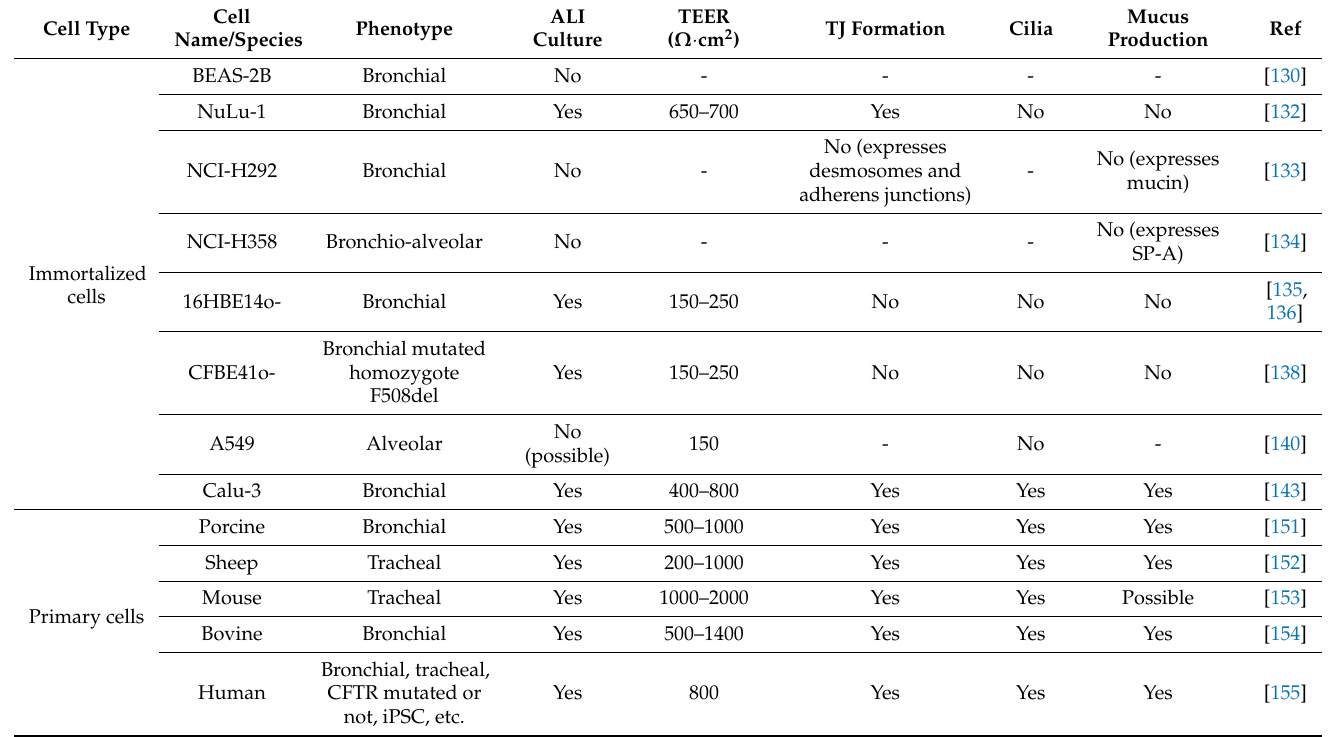
Table 2. Examples of commonly used immortalized airway epithelial cells and primary cell